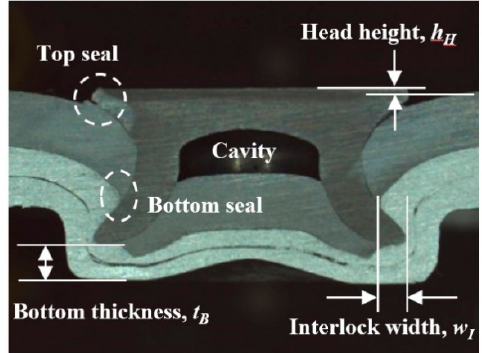
Figure 4. Geometrical indexes and the seals of a self-piercing riveted joint.